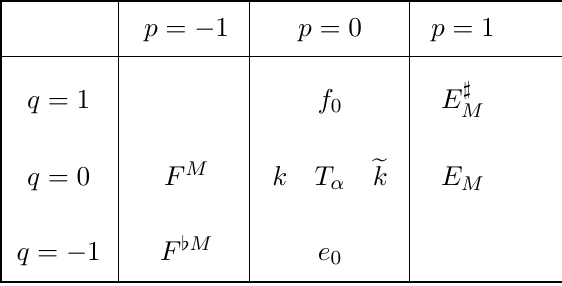
Table 2 . Basis elements for B ( g + ) at p = (cid:0) 1 ; 0 ;